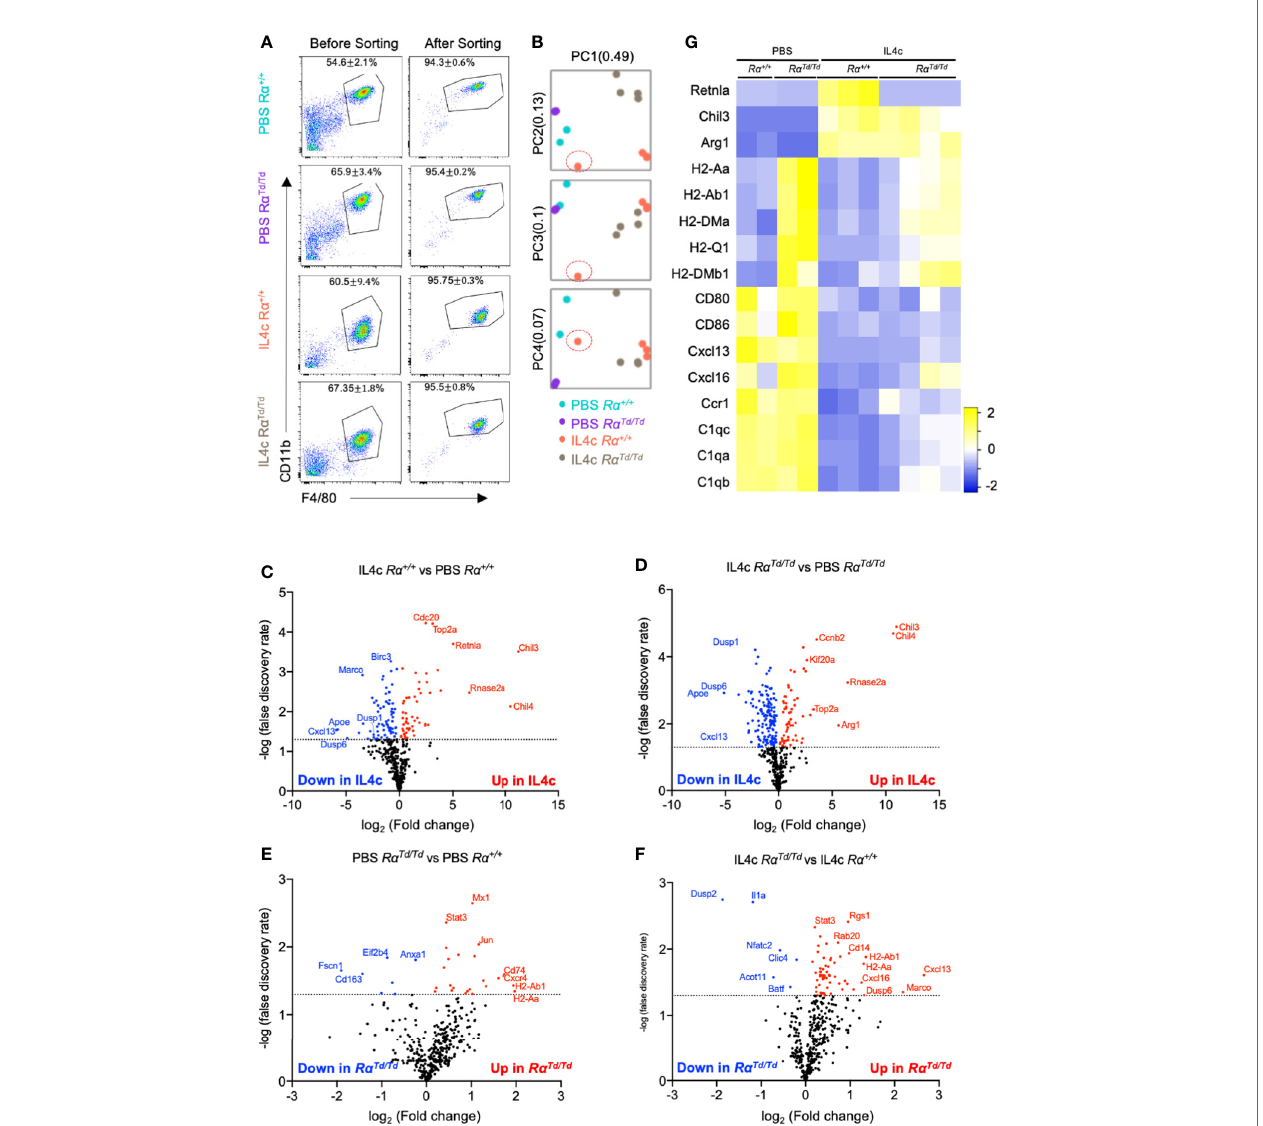
FIGURE 3 | Gene expression analysis of peritoneal macrophages identify IL-4-induced and suppressed genes that are regulated by RELM a . Peritoneal macrophages were sorted from PBS or IL4c-injected R a +/+ or R a Td/Td mice and analyzed by using the Nanostring myeloid gene expression panel. (A) Flow cytometry gating strategy and purity. (B) Principal component analysis demonstrates sample clustering. (C – F) Volcano plot of genes that are most changed in response based on IL-4c treatment (C, D) or genotype (E, F) . (G) Heatmap of canonical macrophage activation genes in different groups. Nanostring gene expression data are from a single experiment (n=2 for PBS and n=4 for IL-4c